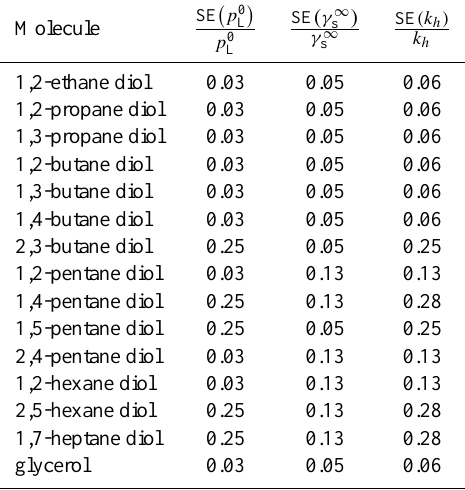
Figure 2. (a) Activity coefficient correction (log 10 γ ∗ s ) of the organic solute vs. RH for an AS–water particle, as calculated by AIOMFAC. (b) Particulate fraction of the organic solute vs. RH. Acid dissociation is not taken into account. Tartaric and citric acid have f p = 1 over the entire presented range. (c) , as (b) , but taking acid dissociation into account using the on-line model of E-AIM (see text for more details). Oxalic, malonic, tartaric and citric acid have f p = 1 over the entire presented range. Table 7. Estimated relative standard errors on p 0 , γ ∞ s and the re- L sulting relative standard error on k h . See Sects. A1 and 53